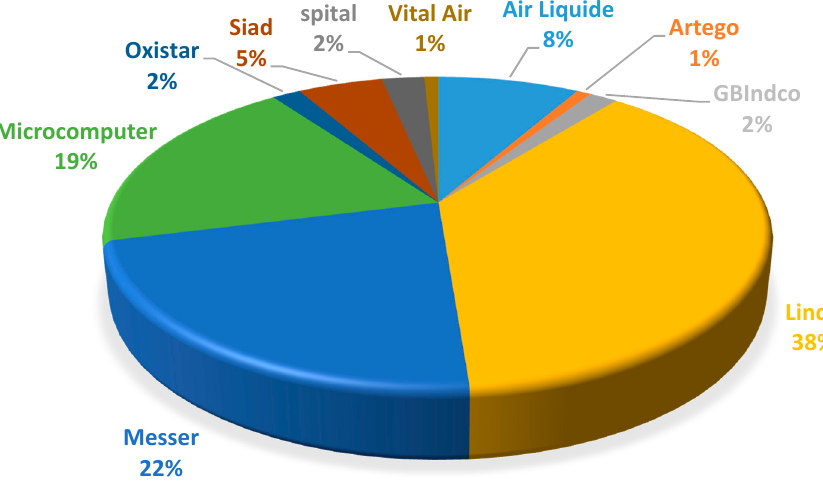
Figure 3. Main suppliers in the Romanian market of medicinal oxygen.